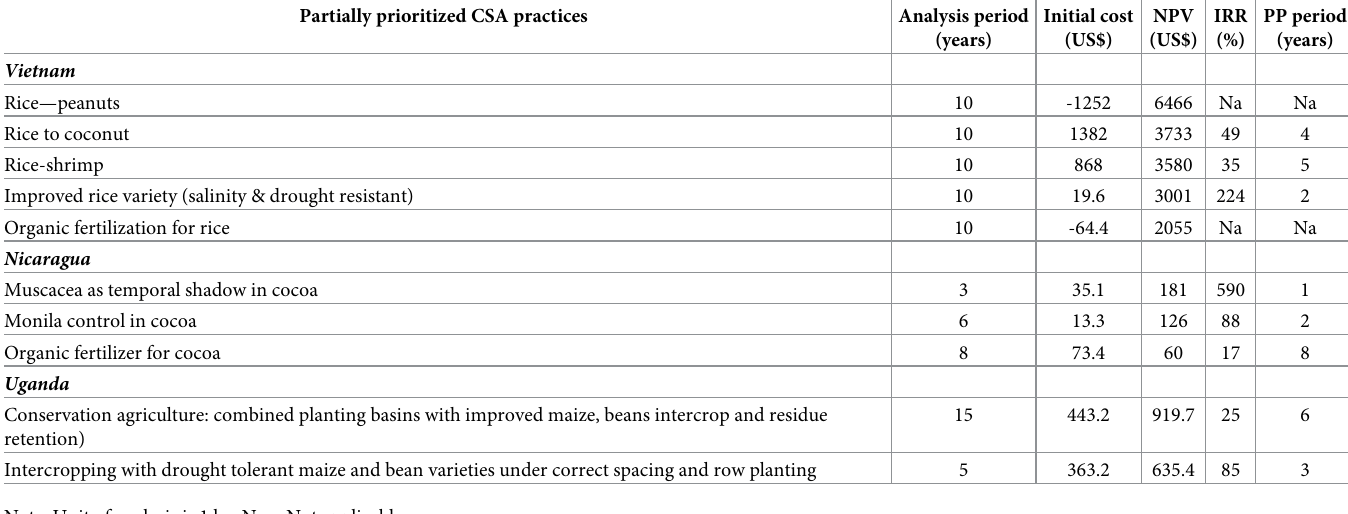
Table 4. Farm-level cost benefit analysis of prioritized CSA practices in the three case